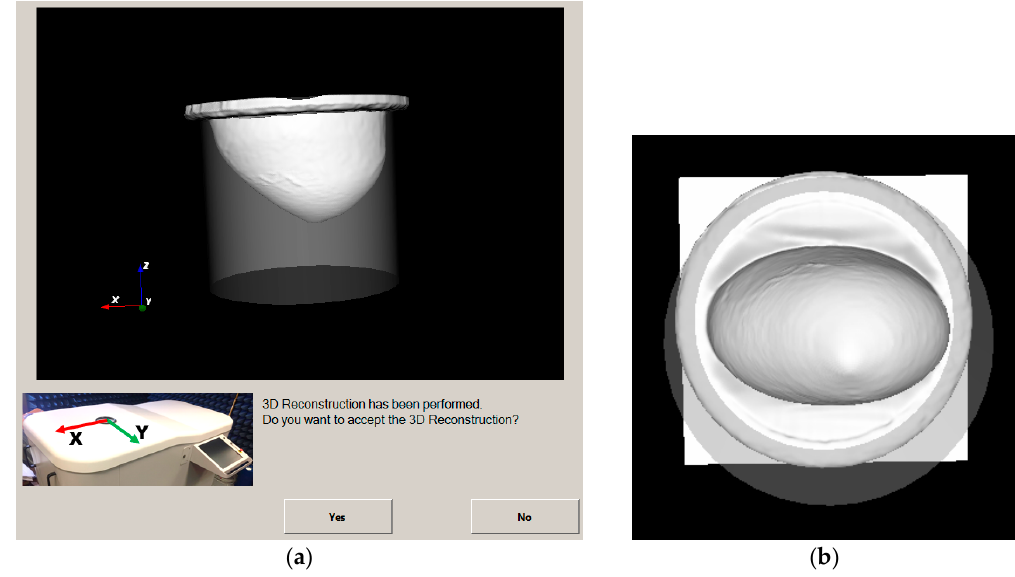
Figure 11. Reconstructed outer surface of a second breast phantom #2, of significantly bigger size, ( a ) Screen capture from the Wavelia Optical Breast Contour Detection subsystem, as provided to the user, ( b ) Zoomed bottom view of the reconstructed outer surface of the breast. Table 1. Breast Phantom Metrology, Based on the Optical Scan.